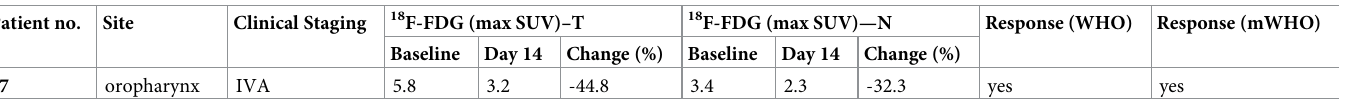
Change in primary tumor and maximum standard uptake value (SUV) of regional lymph nodes after the first induction chemotherapy (IC), and WHO and mWHO criteria for each individual patient (after the second cycle of IC). N =